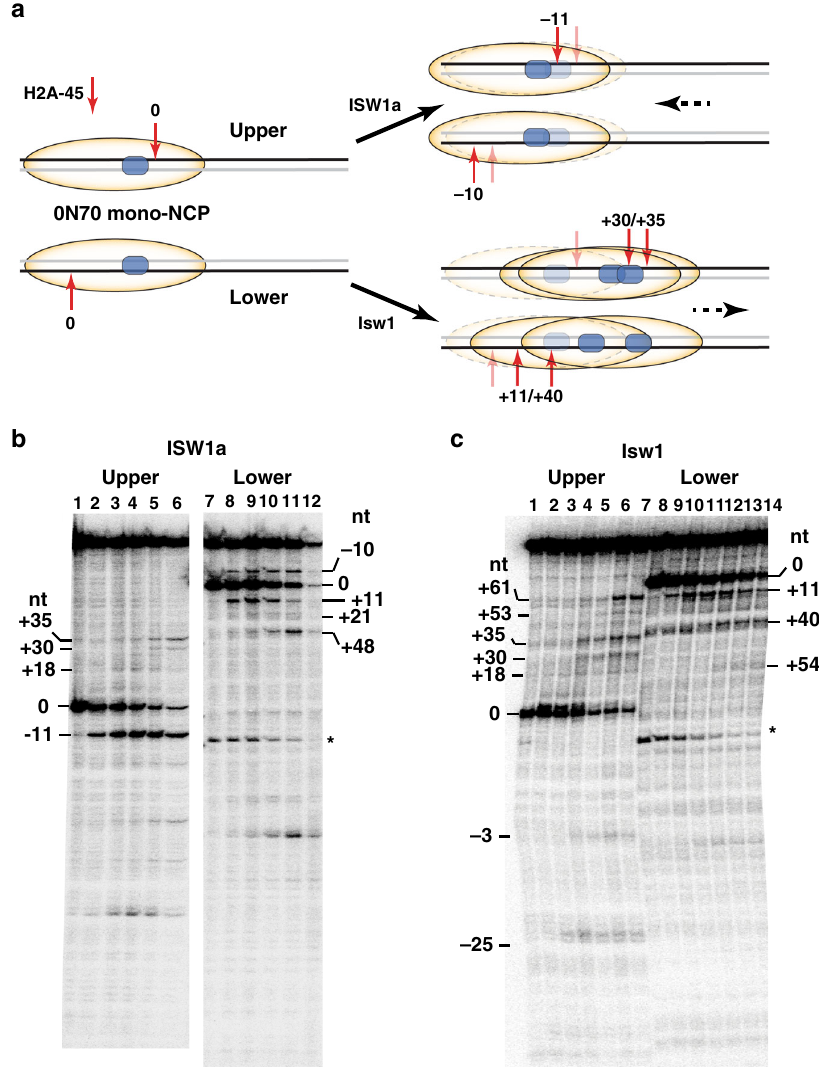
Fig. 3 The Ioc3 subunit reduces nucleosome mobilization by promoting backtracking of Isw1. a DNA movement during remodeling of 0N70 nucleosomes was tracked by mapping DNA contacts with histones by modifying residue 45 of histone H2A (red arrow) and photocrosslinking DNA as depicted. Two sides of the dyad axis are tracked by labeling either the upper or lower strands with 32 P at the 5 ′ end of DNA. The labeled strand is shown in black and the unlabeled strand in gray. Shown in the schematic is the nucleosome movement on DNA when remodeled either by ISW1a or Isw1 and the starting contact point is referred to as zero. The bound location of the ATPase domain is shown in blue. The remodeled nucleosome positions are shown along with an outline of the original nucleosome for reference. b , c The phosphorimages are shown for ( b ) ISW1a and ( c ) Isw1 samples analyzed on a 6% polyacrylamide with 8 M urea. Nucleosomes with the upper (lanes 1 – 6) or lower (lanes 7 – 12) DNA strands labeled were separately analyzed and experiments were done with n = 3 independent